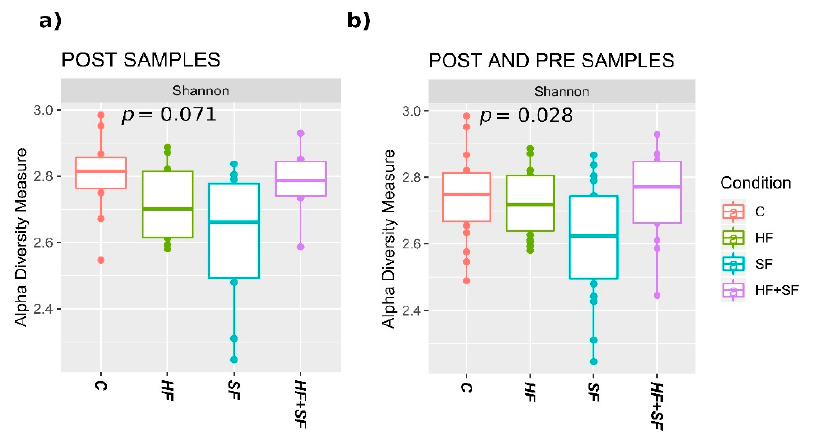
Figure 4. Shannon index representation of the paired samples according to the Condition variable. The line inside the boxplot represents the median for each of the groups. ( a ) Considering only post samples. Kruskal-Wallis test showed a non-significant result ( p = 0.071). ( b ) considering both pre and post samples. Kruskal–Wallis test showed significance ( p = 0.028).